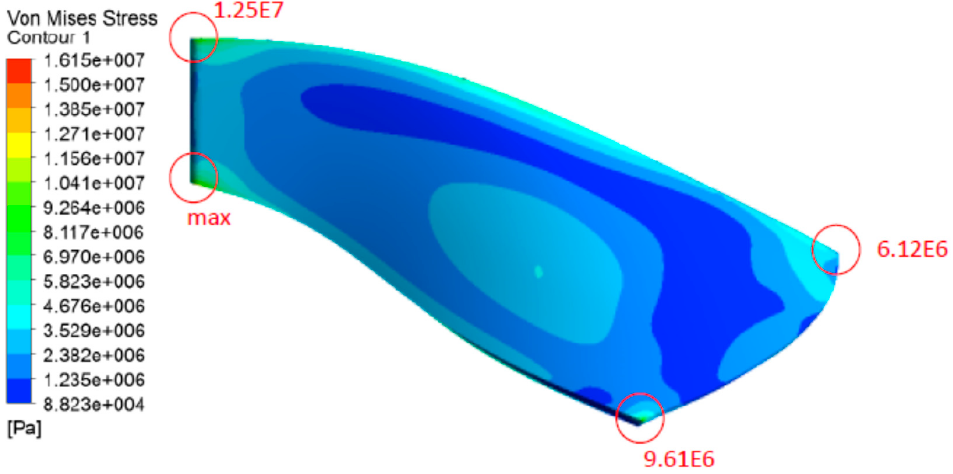
Figure 10. Stress distribution on the blade from two-way FSI [25].